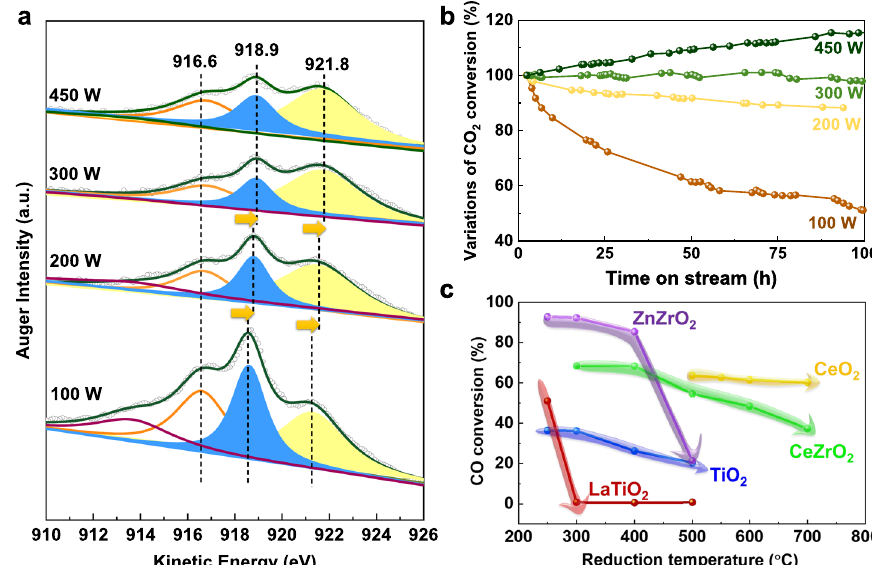
Fig. 4 Regulation of classical SMSI on Cu-based catalysts. a Cu LMM XAES spectra of SP-Cu/LaTiO 2 with different energy power. b CO 2 conversion variation with TOS during RWGS reaction at 600 °C. c CO conversion of Cu-based catalysts by sputtering Cu on various supports, such as LaTiO 2 , TiO 2 , ZnZrO 2 , CeO 2 , and CeZrO 2 in CO + NO reaction as a function of reduction temperature in the pretreatments, where the reduction was conducted at different temperatures for 1 h in pure H 2 before each reaction at 250